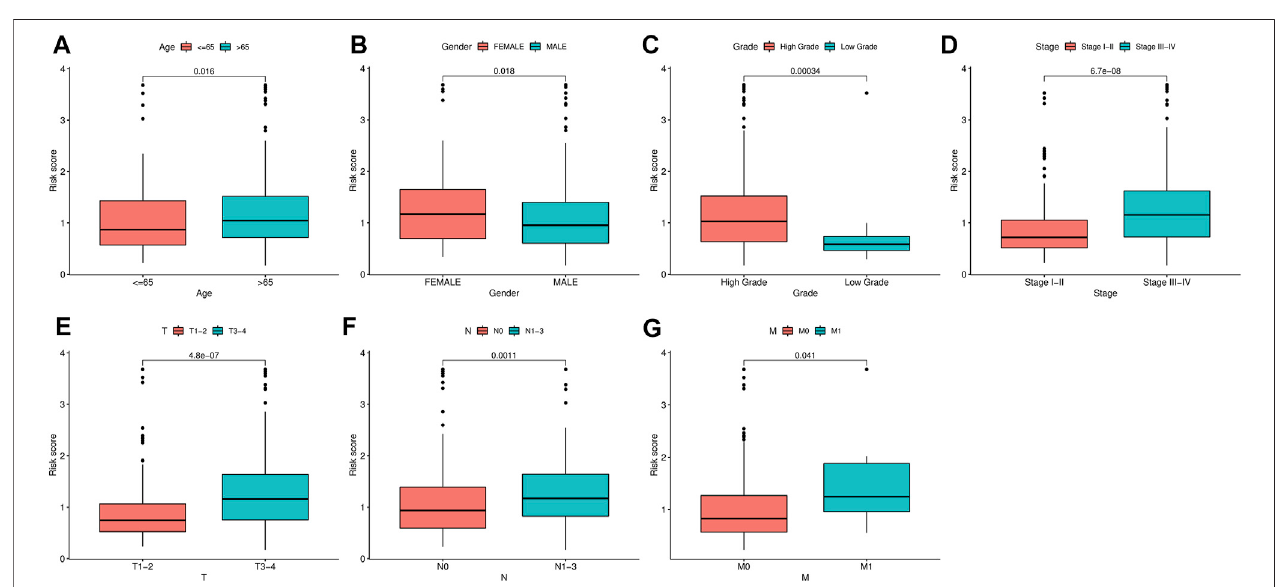
FIGURE6| Correlationanalysisbetweenclinicalcharacteristicsandriskscores(RSs). (A – G) TherelationshipbetweenRSandgender,tumorstage,tumorgrade,T classi fi cation, and M classi fi cation of bladder urothelial carcinoma (BLCA) patients.